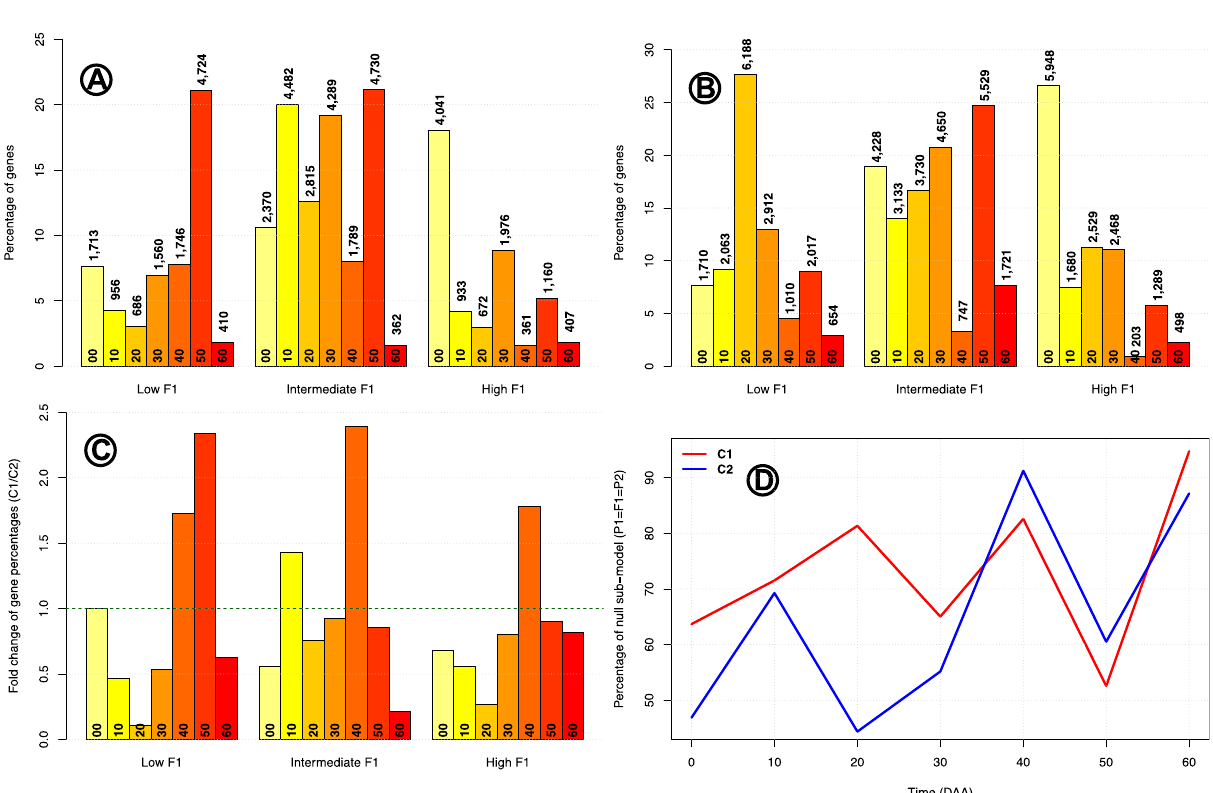
Figure 4. Frequency of class per time of fruit development. In panels ( A–C ) bars present values per class (label in X -axis) and time of development (at bottom of each bar). Null sub-model ( P 1 = F 1 = F 2 ) is not included. Panels ( A,B ) give percentages of genes per class × time combination for crosses C 1 and C 2 , respectively. Number of genes are presented over each bar. Panel ( C ) gives fold change for percentages C 1 / C 2 for each class × time combination; the green line at Y = 1 denotes equality of proportion. Panel ( D ) gives percentages of null sub- model ( P 1 = F 1 = F 2 ) in Y -axis as function of time of development in X -axis per